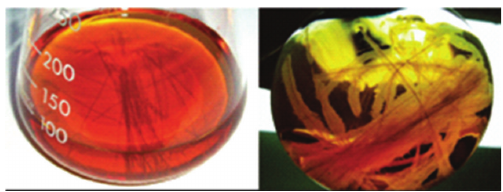
Figure 8: Photographs of sisal fibers before and after bacterial culture [61].